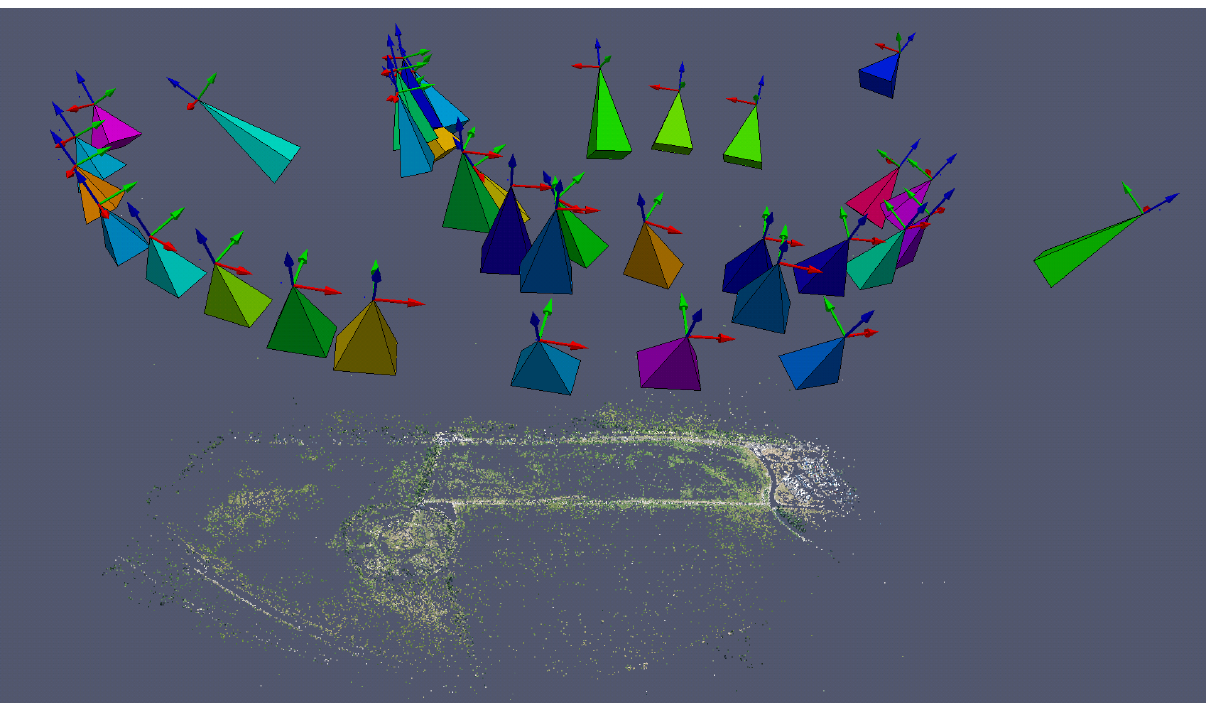
Figure 4: Automatically oriented archaeological APs of Roman Carnuntum , Austria, together with the reconstructed, sparse point